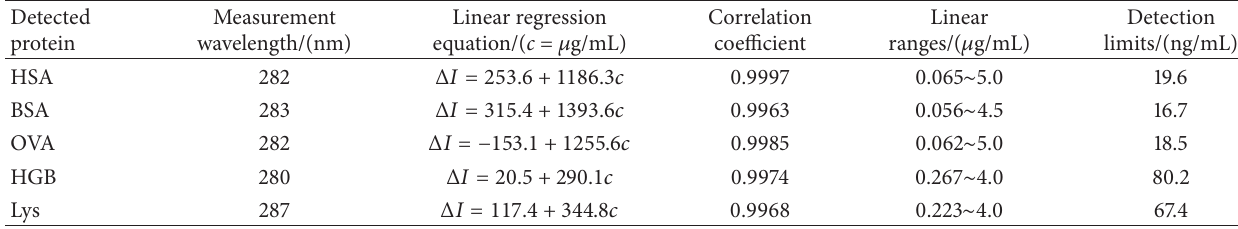
Table 1: Linear ranges, correlation coefficient, and detection limits.